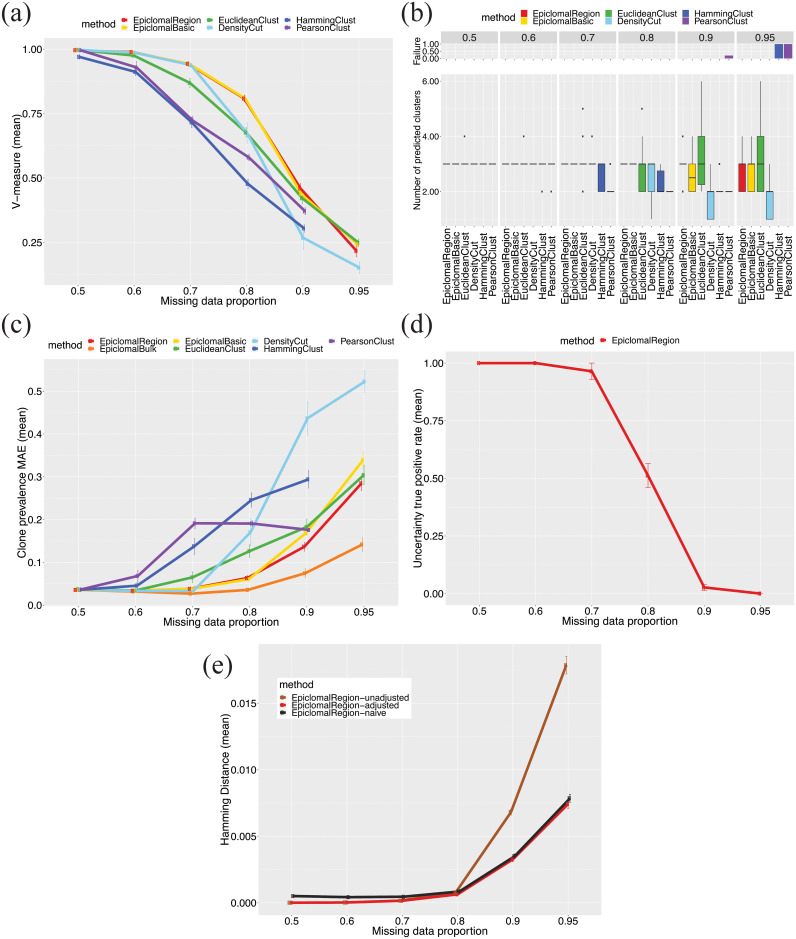
Simulation results when varying the missing data proportion.We report mean results produced by Epiclomal and the non-probabilistic methods taken over 30 randomly generated synthetic datasets: (a) V-measure; (b) Number of predicted clusters (true is 3); the top panel shows the proportion of data sets for which a method failed to produce a result; (c) Epiclone frequency (prevalence) MAE (mean absolute error); (d) Uncertainty true positive rate; and (e) Hamming distance for three variants of EpiclomalRegion inferred methylation states: unadjusted, adjusted, and naive (see Sections 1.2 and 3.4 in S1 Material). The vertical bars correspond to one standard deviation above and below the mean value.